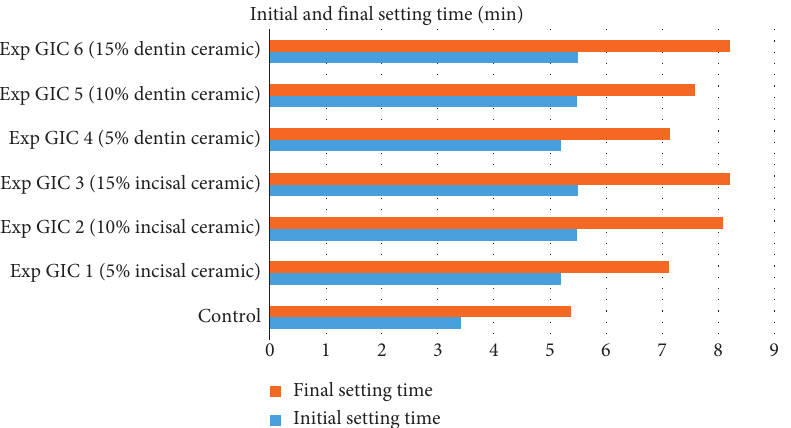
Figure 5: Setting time of samples in Group